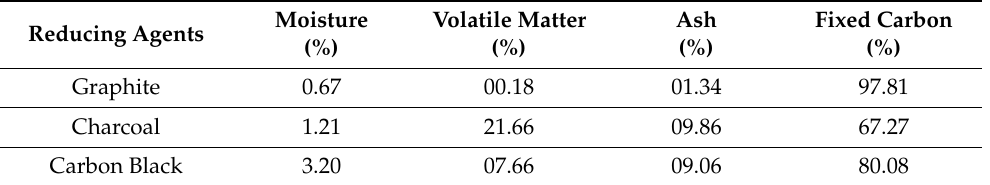
Table 3. Proximate analysis of reducing agents.